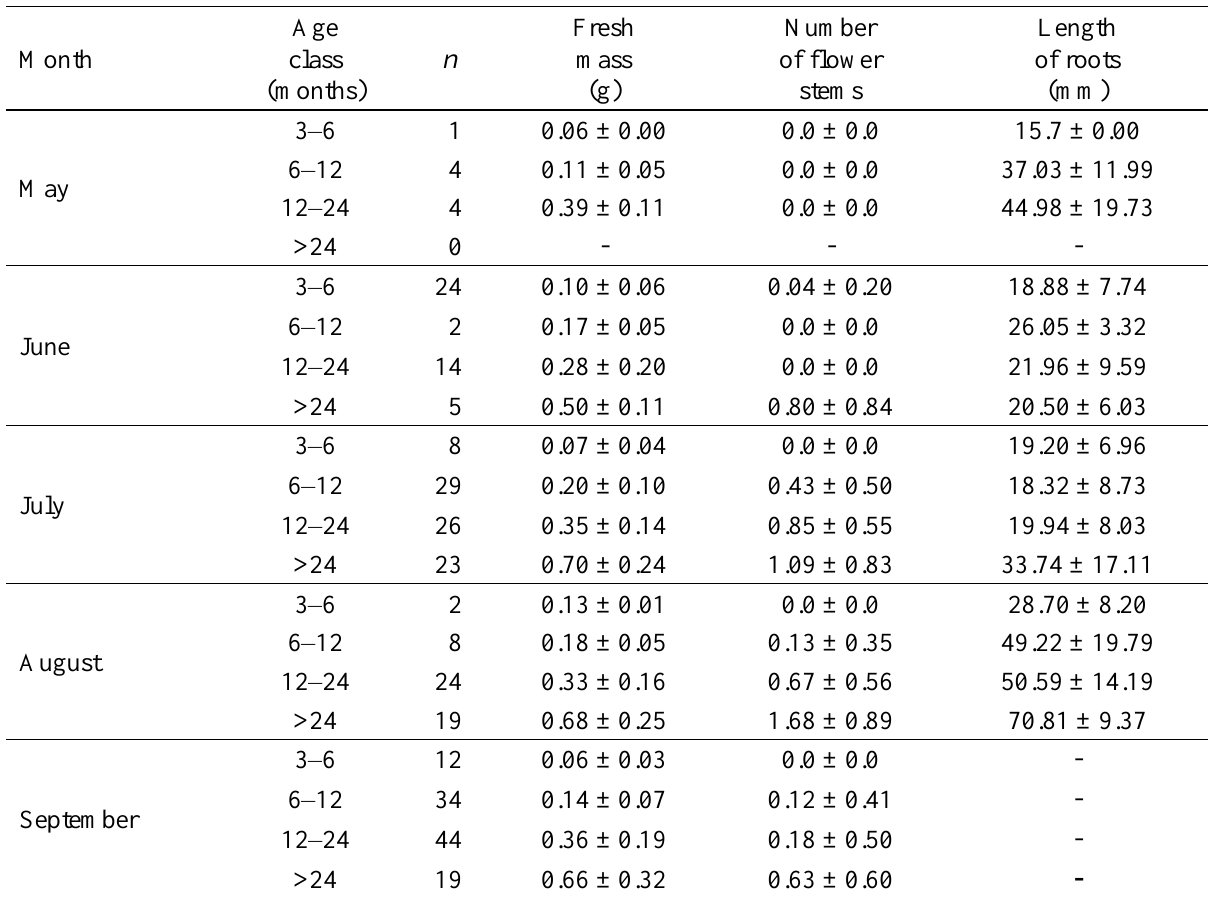
Table A3. Morphological features of Drosera intermedia growing on the Sphagnum papillosum field in 2013 and 2014; mean values ± SD . In September (2013 and 2014) the length of roots was not measured. n = number of individual plants.